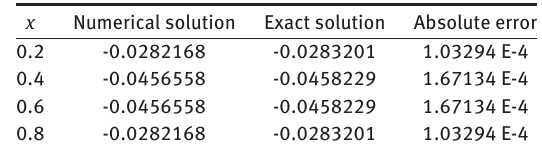
Table 4: The numerical resultes for third problem at y = 0.4, x , y ∈ [0, 1]